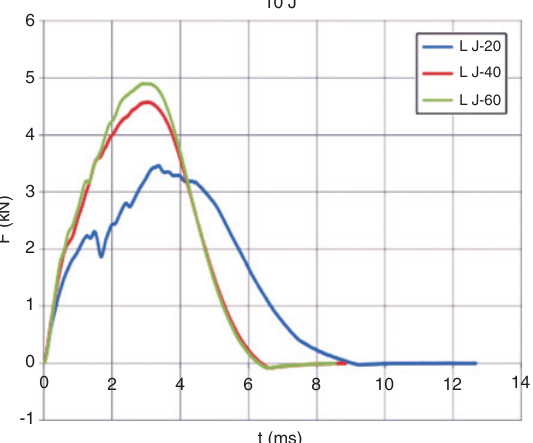
Figure 7 Variation of the contact load vs. contact time of composite single-lap